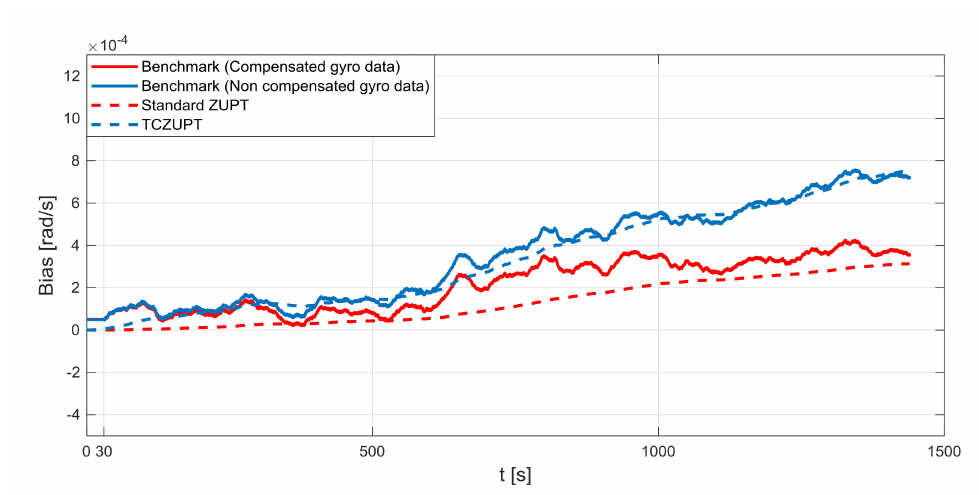
Figure 15. Gyro output bias (residual error of 15 degree/h, y